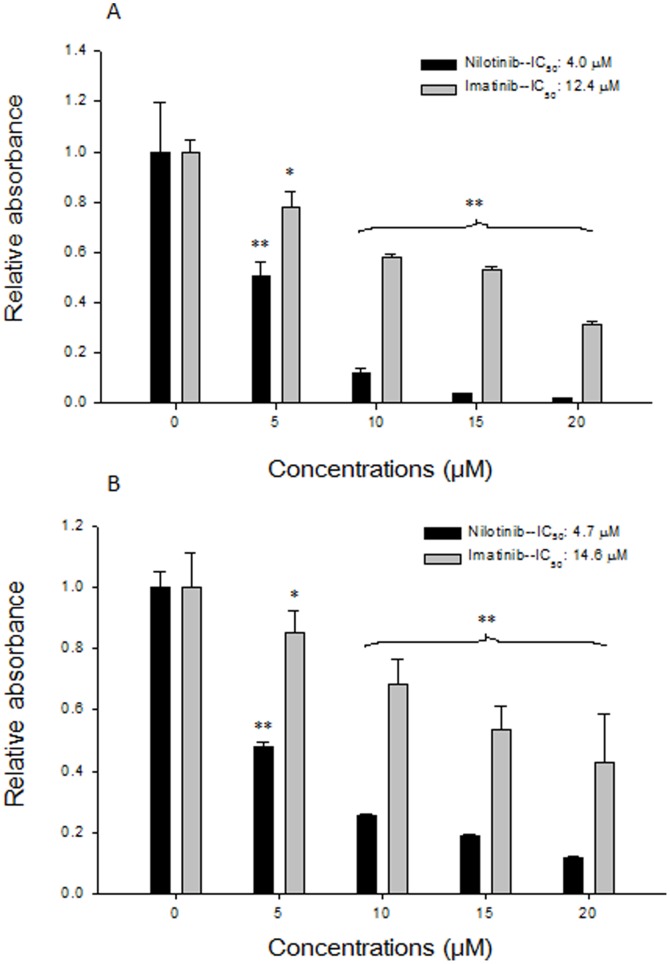
Effects of imatinib and nilotinib on proliferation (A) and viability (B) of PNF-derived Schwann cells.Data are absorbance normalized to that of untreated controls. Significant (P<0.05) and highly significant (P<0.001) differences were marked with * and **, respectively.